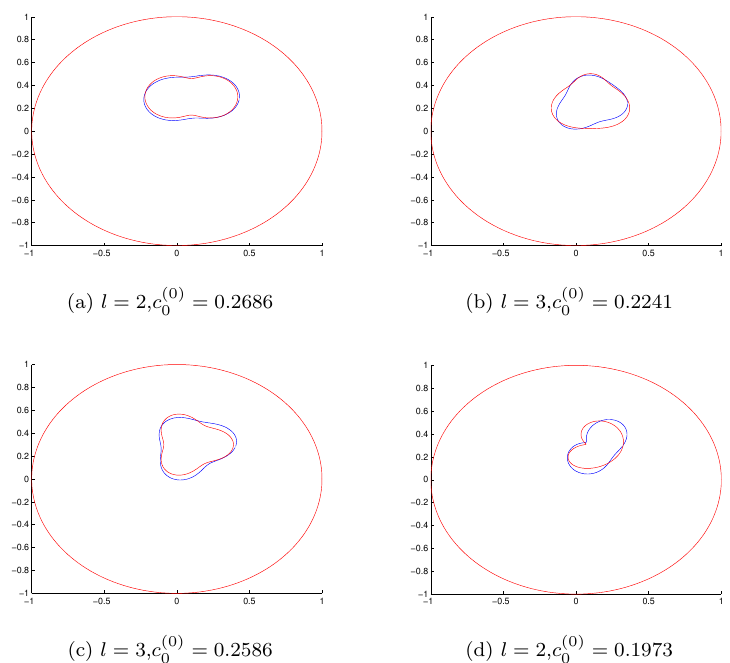
Figure 8. (a) Peanut; (b) peach; (c) pear; (d) bean. Apply TRA to reconstruct the shape of the coefficient with 1% noise data along with exact solution (red) and recovered